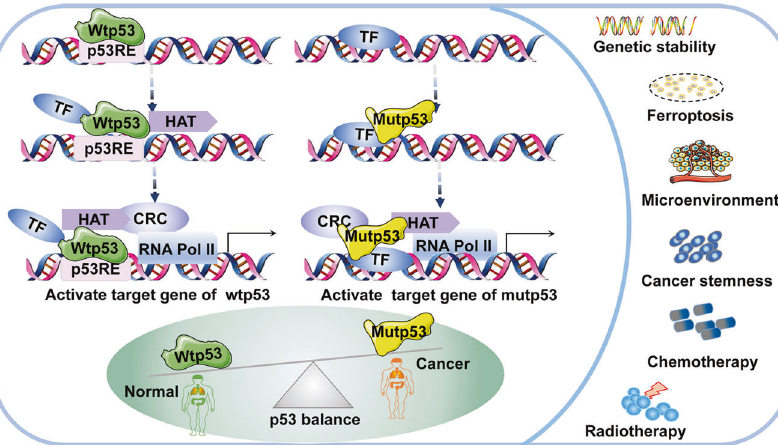
Fig. 3 The transcriptional model of mutp53 and its function in tumors. Transcriptional model of mutp53 and its function in tumors. In contrast to wtp53, mutp53 cannot bind directlyto DNA RE and it exerts function through interactions with